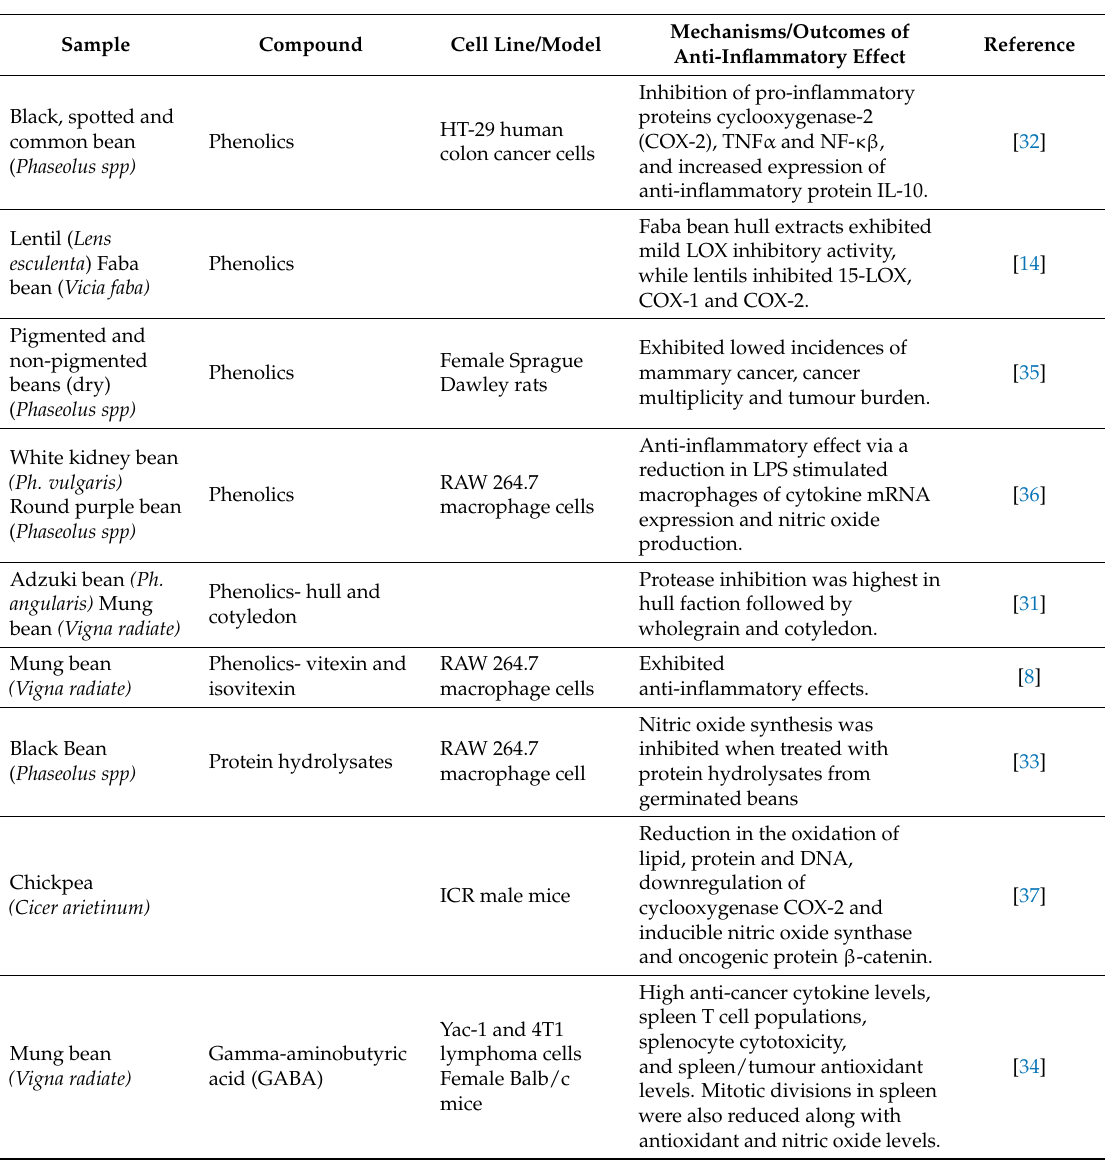
Table 1. Anti-inflammatory potential of pulse bioactive